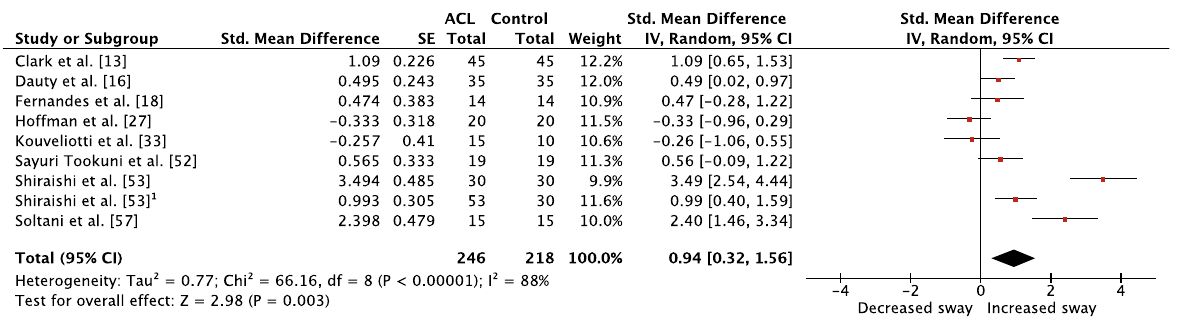
Fig. 2 Forest plot comparison of sway magnitude between the ACL-injured and ACL-matched control leg. Std . standardized, SE standard error, IV inverse variance, CI confidence interval, df degrees of freedom, ACL anterior cruciate ligament. 1 Second ACL group in the same study